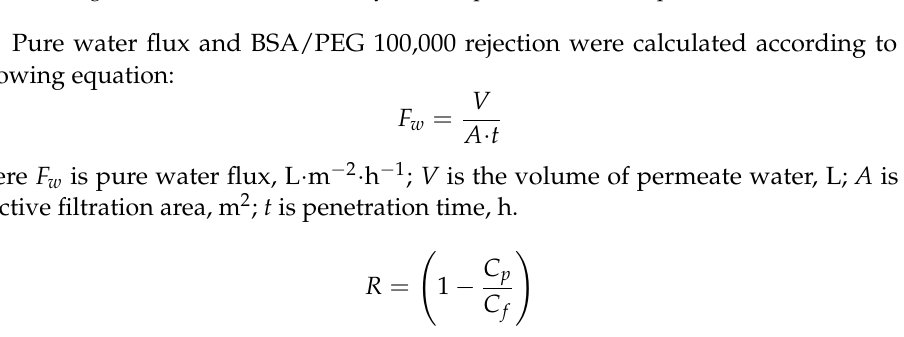
Figure 1. Diagram of crossflow filtration system for permeation and separation test.